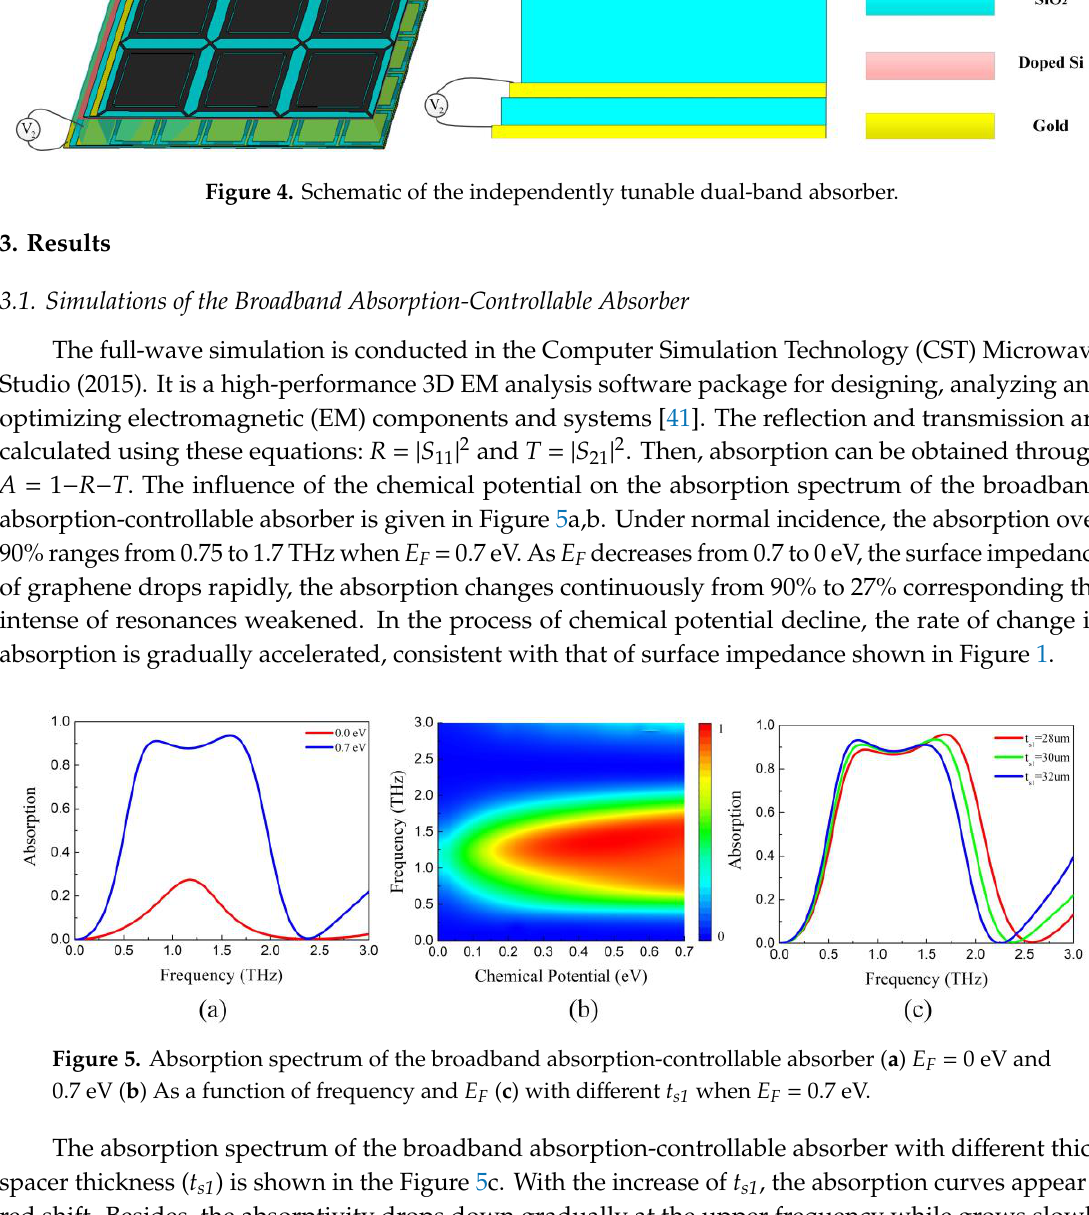
Figure 4. Schematic of the independently tunable dual-band absorber.